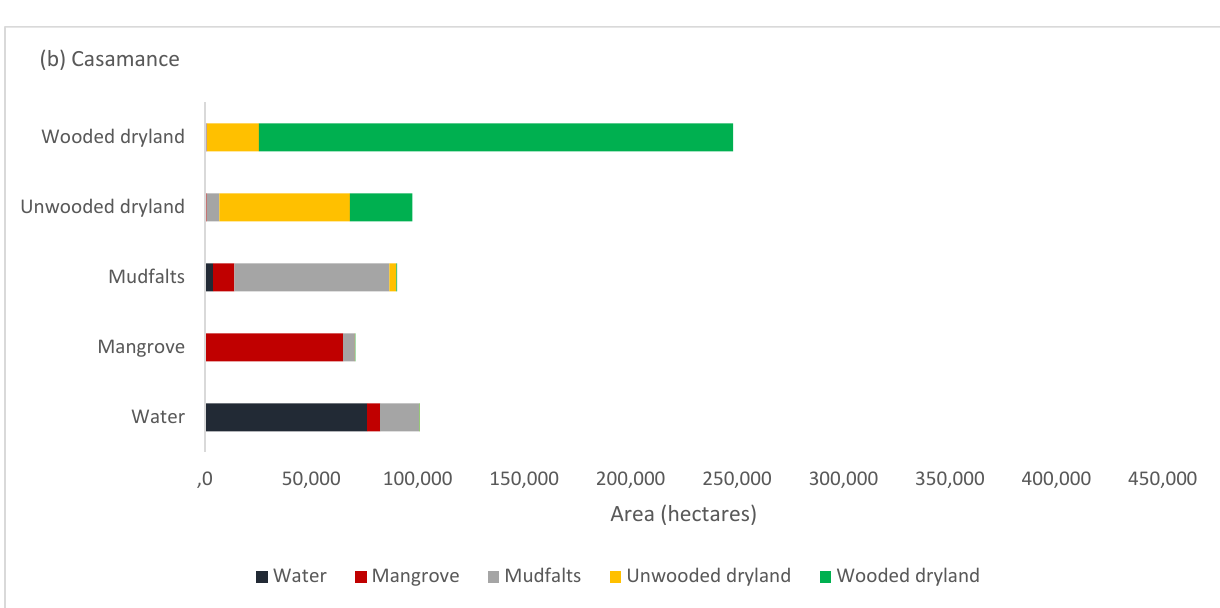
Figure 6. Land cover change and contribution of classes to the area change between 2000 and 2018 in Saloum ( a ) and Casamance ( b ).